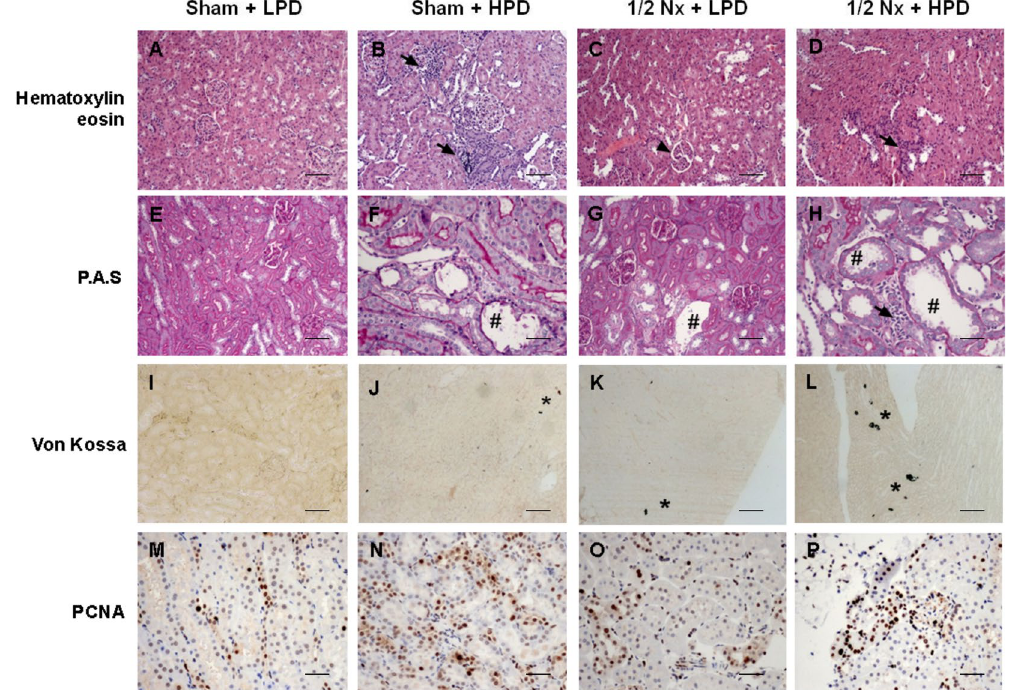
Figure 3. Excessive phosphaturia promotes renal injury. Renal samples from Sham + LPD, Sham HPD, 1/2Nx + LPD and 1/2Nx + HPD groups of rats were analyzed with hematoxilin-eosin staining ( A – D ), periodic acid staining ( E – H ), von Kossa ( I – L ) and PCNA immunostaining ( M – P ). Arrows: inflammatory reaction and hypercellularity; Arrowhead: glomerulus lobulation; # Acute tubular necrosis; * presence of phosphate deposits. Magnification: x100. Scale Bar: 50 µ